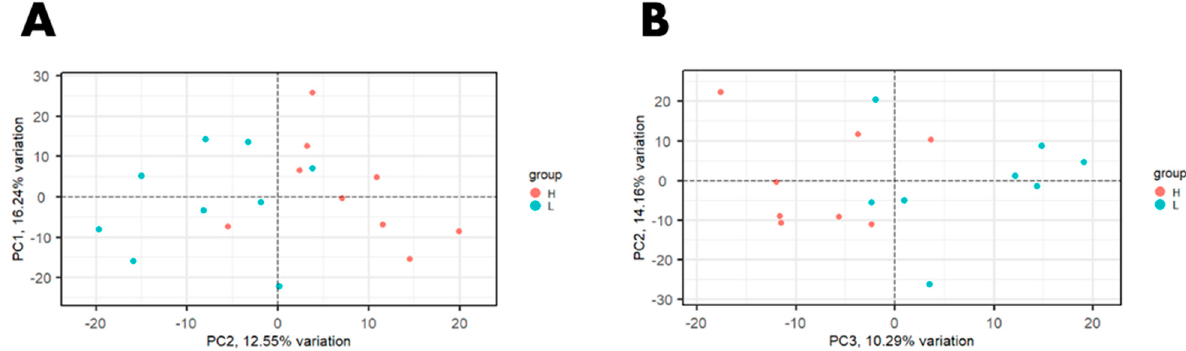
Figure 2. Principal component analysis (PCA) plot of normalized gene expression values in steers with high and low residual feed intake from ( A ) a Canadian population and ( B ) a United States population.